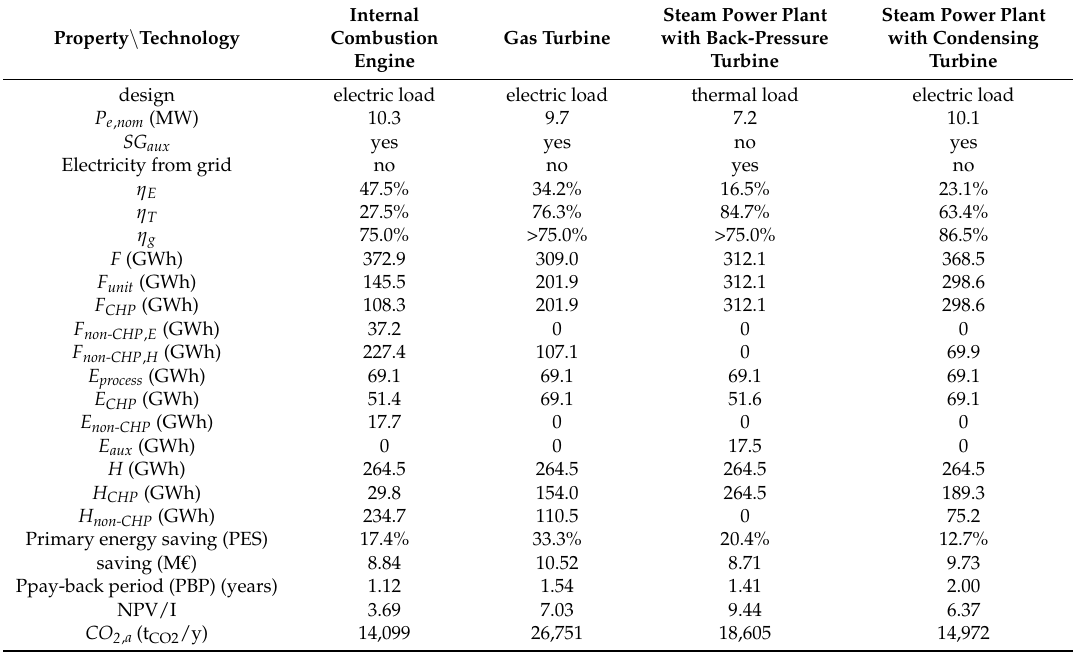
Table 4. Properties and energy balances for the considered cogeneration units (optimal design).